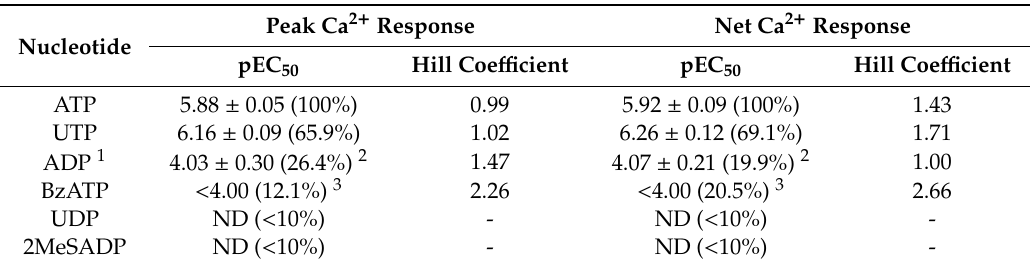
Figure 2. Nucleotide-induced Ca 2+ response profiles for DH82 cells. ( A – I ) DH82 cells in extracellular Ca 2+ solution (ECS) were loaded with Fura-2, incubated in the absence (basal) or presence of each nucleotide (as indicated) and Fura-2 fluorescence was recorded. Ca 2+ traces (ΔF340/380) for ( A ) 100 µM adenosine 5′-triphosphate (ATP) ( n = 6), ( B ) 30 µM uridine 5′-triphosphate (UTP) ( n = 3), ( C ) 100 µM adenosine 5′-diphosphate (ADP) (preincubated with 4.5 U/mL hexokinase for 1 h at 37 °C) ( n = 3), ( D ) 300 µM 3’- O -(4-benzoyl)benzoyl-ATP (BzATP) ( n = 3), ( E ) 30 µM uridine 5′-diphosphate (UDP) ( n = 3) and ( F ) 100 µM 2-methylthio-ADP (2MeSADP) ( n = 3). ( G ) One phase decay time (τ) calculated from the peak of each Ca 2+ trace, ND = no data. ( H ) Peak nucleotide-induced Ca 2+ responses and ( I ) net Ca 2+ movement were fit to the Hill equation to produce concentration-response curves ( n values correspond to respective individual traces above). ( A – I ) Data shown are the mean ± SEM from three to six independent experiments as indicated. ( G ) * p < 0.05 and *** p < 0.001 between nucleotides as indicated analysed using a one-way ANOVA with Bonferroni post hoc test. Table 1. Nucleotide-induced changes in intracellular Ca 2 + in DH82 cells as measured by half maximal e ff ective